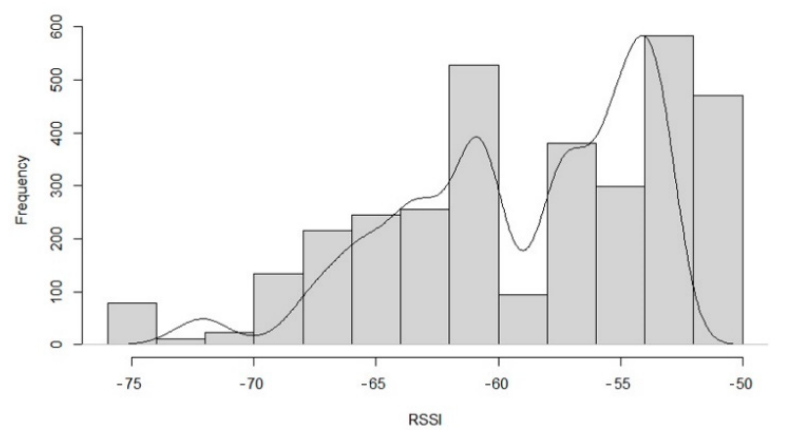
Figure 4. Samples of RSSI distribution over three minutes (3 ft, Sit).